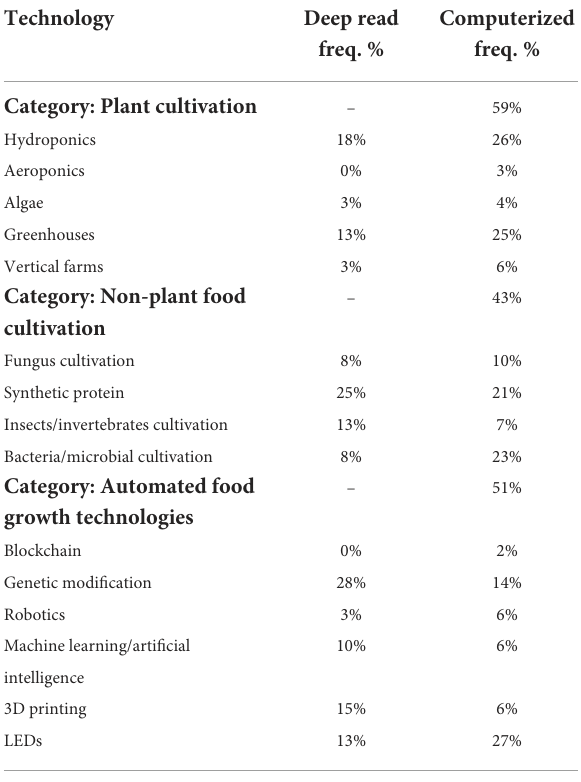
TABLE 1 Specific references to food growth technologies, grouped by deep read analysis frequency and quantitative analysis frequency.